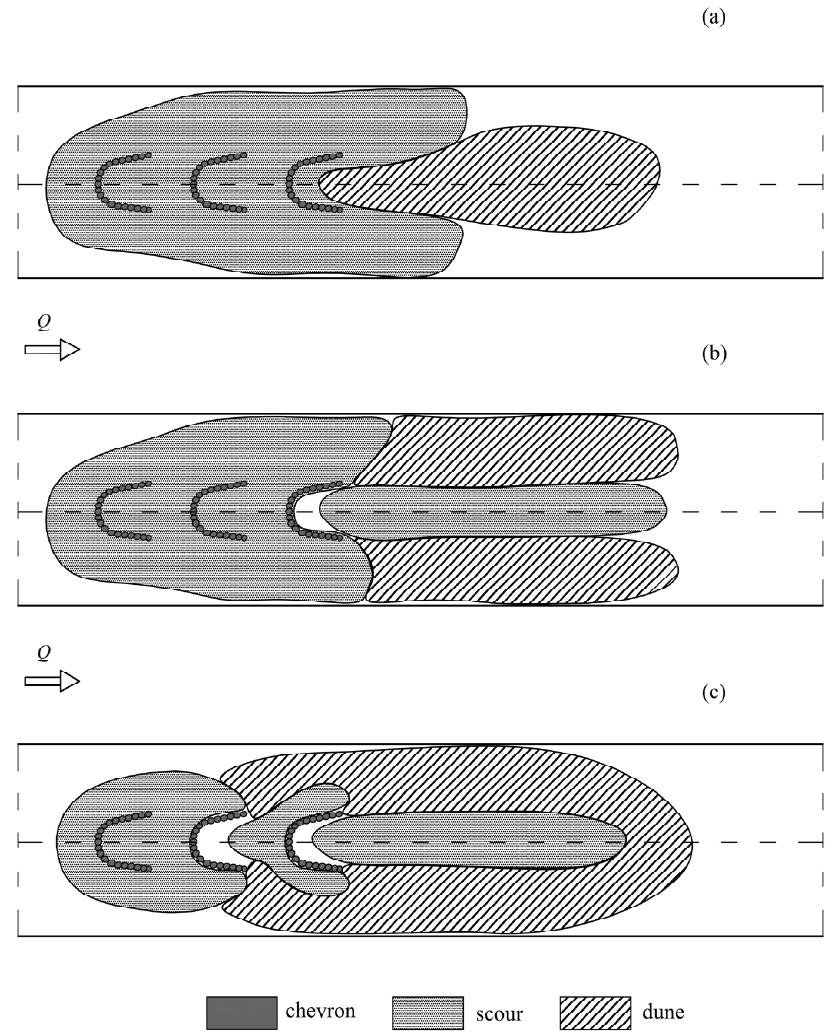
Figure 5. Scour morphology Type ( a ) A , ( b ) B and ( c ) C for p c / B = 0.5 in the case of chevron series arrangement with three structures ( n = 3) in the straight channel.